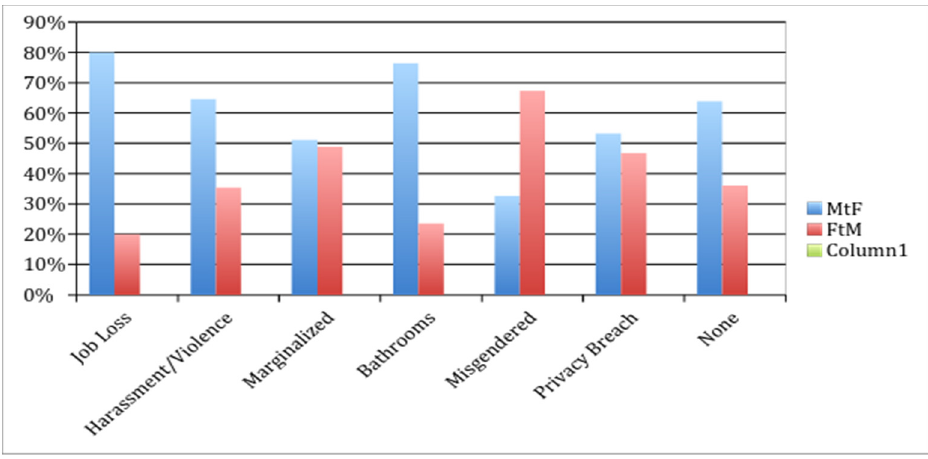
Figure 1. Types of Discrimination by Gender. χ ² (6, N = 554) = 29.726, p ≤ 0.001.